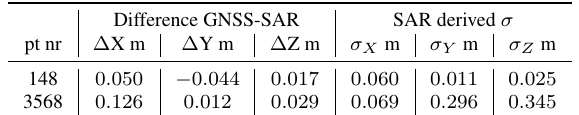
Figure 3. Test area A (Oberpfaffenhofen) and B (Landsberg) with ground control (red stars) and check points (green stars). GX1230 system. Additionally, a subset of geodetic SAR points was validated with terrestrial GNSS system to check the SAR